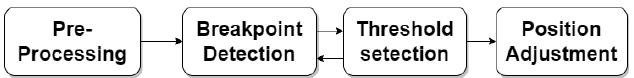
Figure 13. Workflow1: Wavelet decomposition and pressure trend.